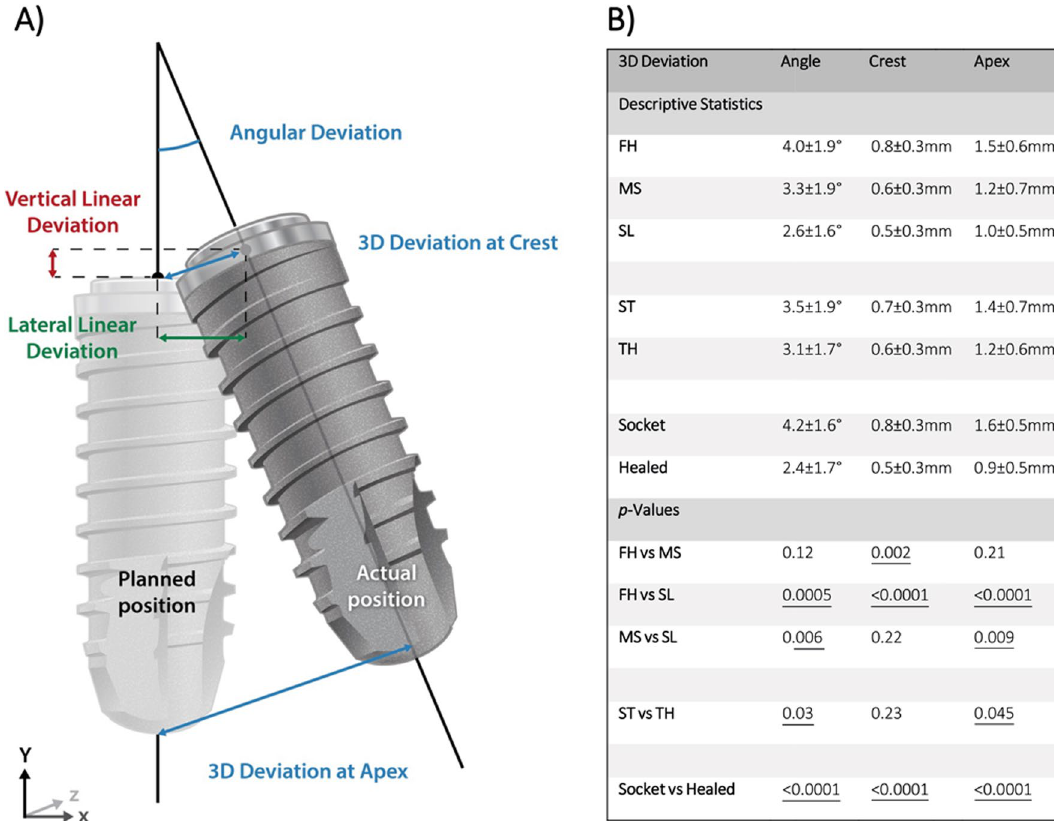
Fig. 3 A Illustration depicting 3D angular, crestal, and apical implant deviation measurements. B Descriptive statistics (means and p ‑values of the 3D angular, crestal, and apical implant deviation for implant placement procedure ( FH free‑handed, MS manufacturer’s sleeve, SL sleeveless), implant system ( ST Straumann, TH Thommen) and alveolar ridge morphology ( socket fresh extraction socket, healed healed alveolar ridge). p ‑values < 0.05 displayed